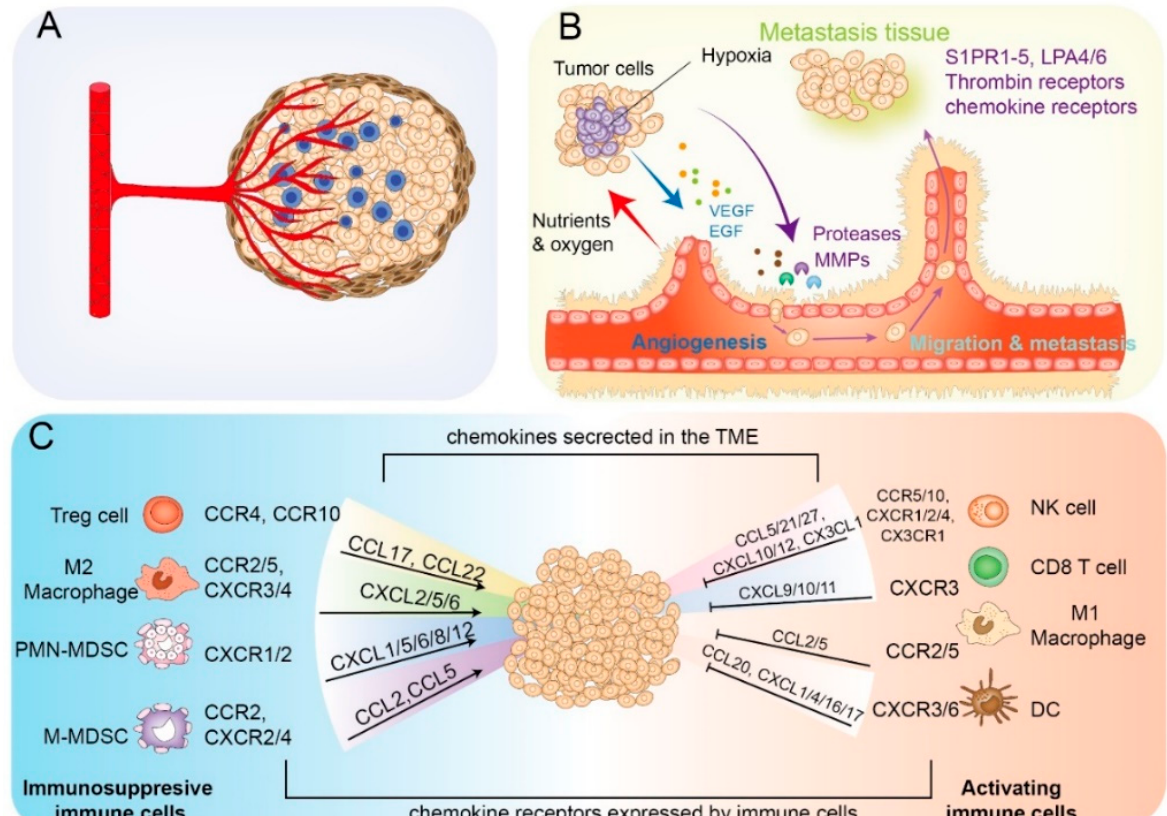
Figure 3. GPCR-mediated metastasis and tumor microenvironment remodeling in GC. ( A ) The TME of GC consists of blood vessels, lymph vessels, immune cells, stromal cells (including fibroblast, pericytes, and adipocytes), extracellular matrix (ECM), and secreted soluble factors, such as proteins, RNAs, and small organelles. ( B ) GPCRs control the process of angiogenesis and metastasis. GPCR activation drives the production of stimulatory angiogenic factors like VEGF and EGF. These factors promote the development of new blood vessels by modulating the mitogenesis, migration, and sprouting of endothelial cells (ECs). Moreover, several GPCRs regulate the metastasis process by influencing ECM, degrading the status of cancer cells (EMT, migration, and invasion), and colonizing foreign sites. ( C ) Chemokine–chemokine receptors modulate immune responses. The chemokines are secreted by tumor cells, immune cells, and stromal cells. The interaction of chemokine and specific receptors recruits antitumor immune cells and immunosuppressive immune cells into the tumor